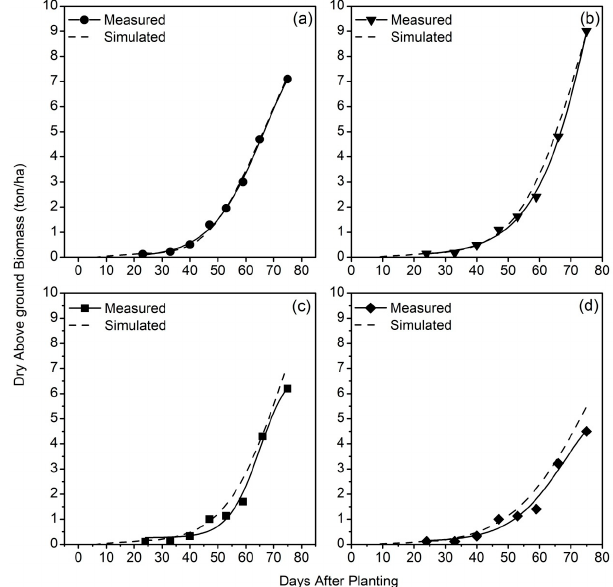
Figure 3. Relationship between dry above ground biomass (D-AGB), (ton / ha), and days after planting (D-AGB ) for 2015 cultivation period and PR91M10 hybrid. The ( a ), ( b ), ( c ), and ( d ) parts depict the 100%, 75%, 50%, and 25% of ET c water treatments, respectively.